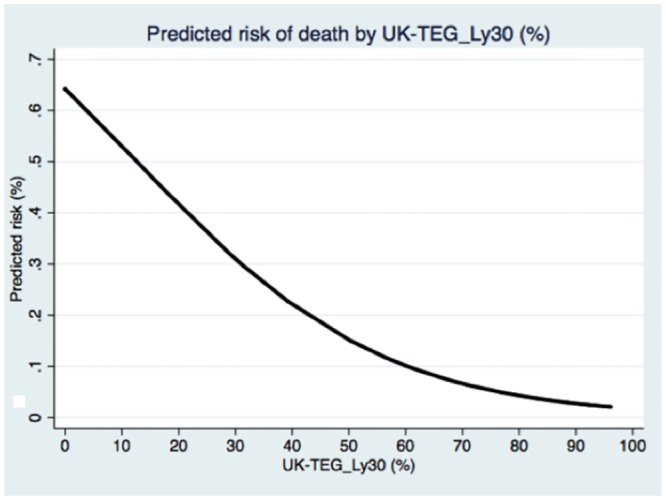
Predicted probability (risk) of death in relation with UK-TEG_Ly30 (%).